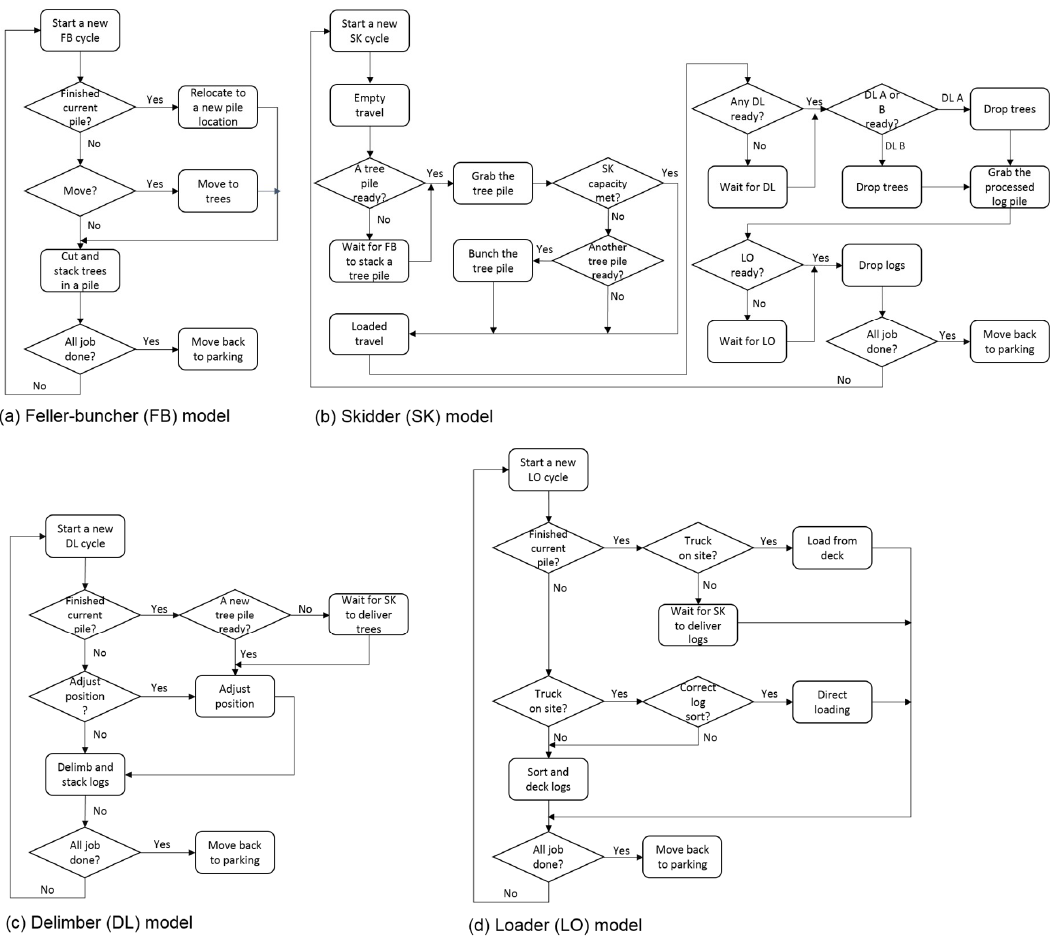
Figure 3. The DES model logic developed for the feller-buncher (FB) ( a ), skidder (SK) ( b ), delimber (DL) ( c ), and loader (LO) ( d ) in the whole-tree harvesting system.